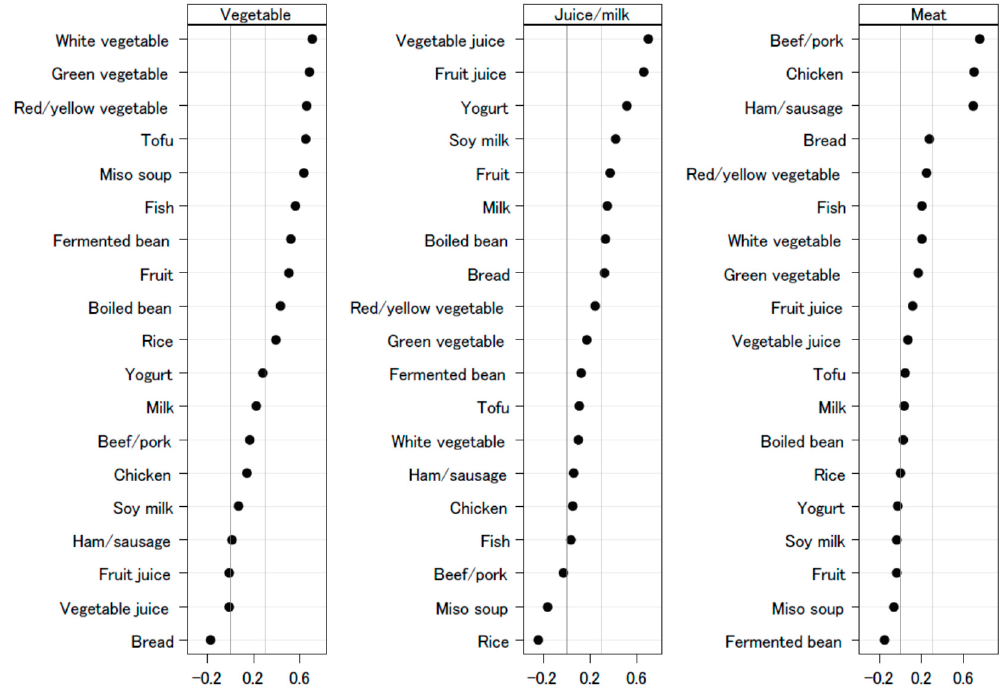
Figure 1. Dietary patterns loadings by food groups, Fukushima Health Management Survey, 2011– 2013.